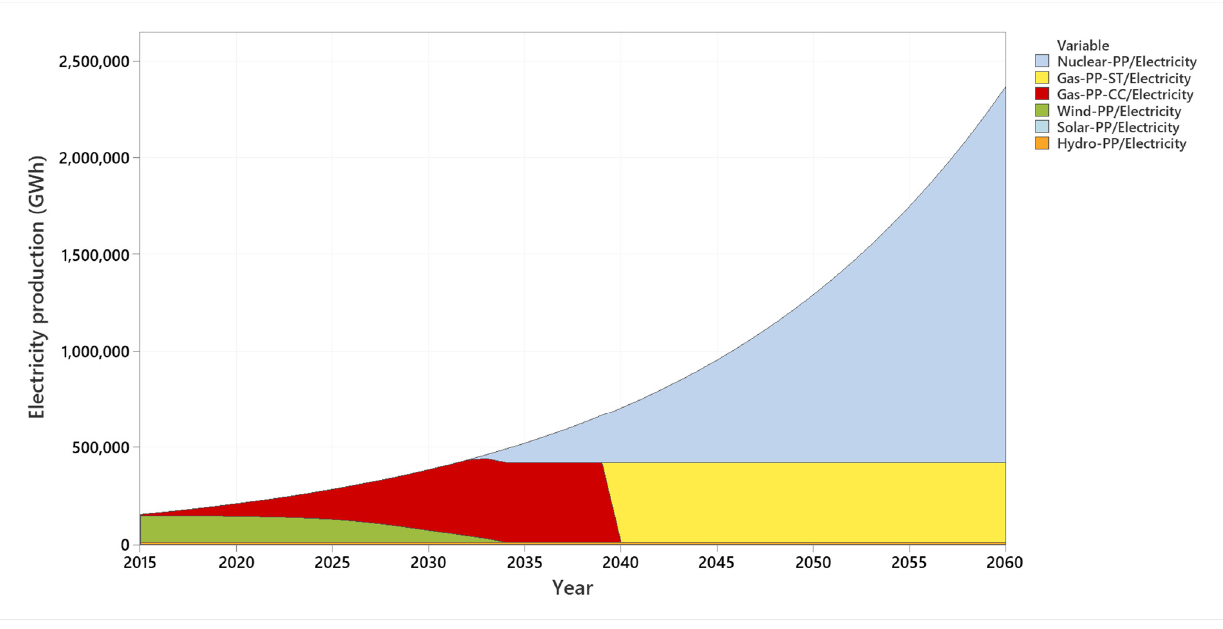
Figure 9. Balance of electricity production of all power plants for fourth scenario.